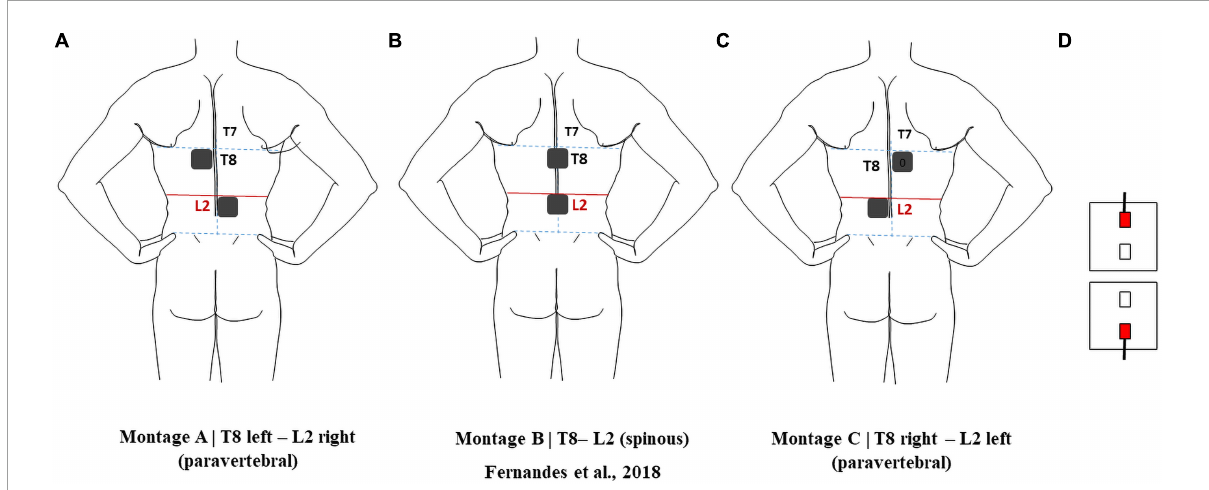
FIGURE1 Electrode montages considered in this report: (A) pvT8 left-pvL2 right; (B) T8-L2; (C) pvT8 right-pvL2 left. (D) Relative position of the active connectors in all montages.